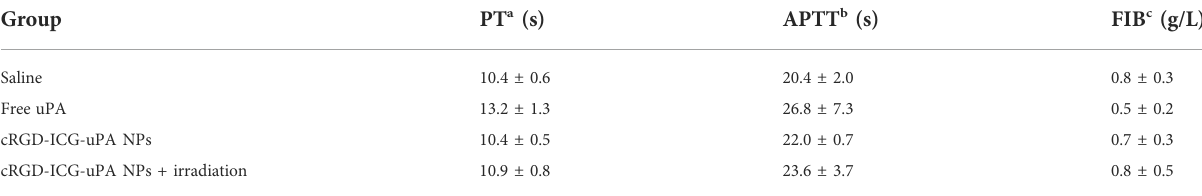
TABLE 1 PT, APTT, and FIB values of mice treated with saline, free uPA (300 U/g), cRGD-ICG-uPA NPs (300 U/g), and cRGD-ICG-uPA NPs (300 U/g) with NIR laser irradiation (0.3 W/cm 2 ) ( n = 5).